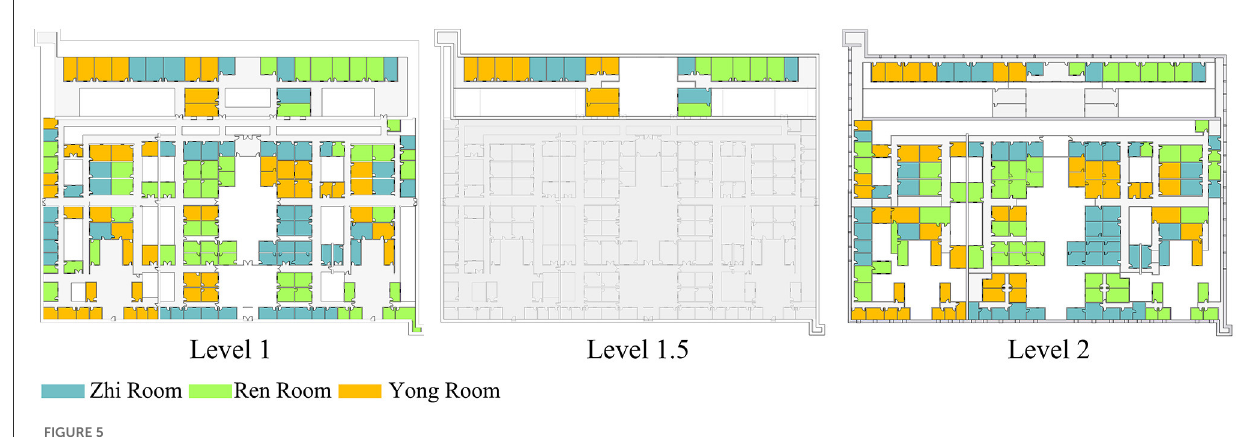
FIGURE5 Distribution of the household